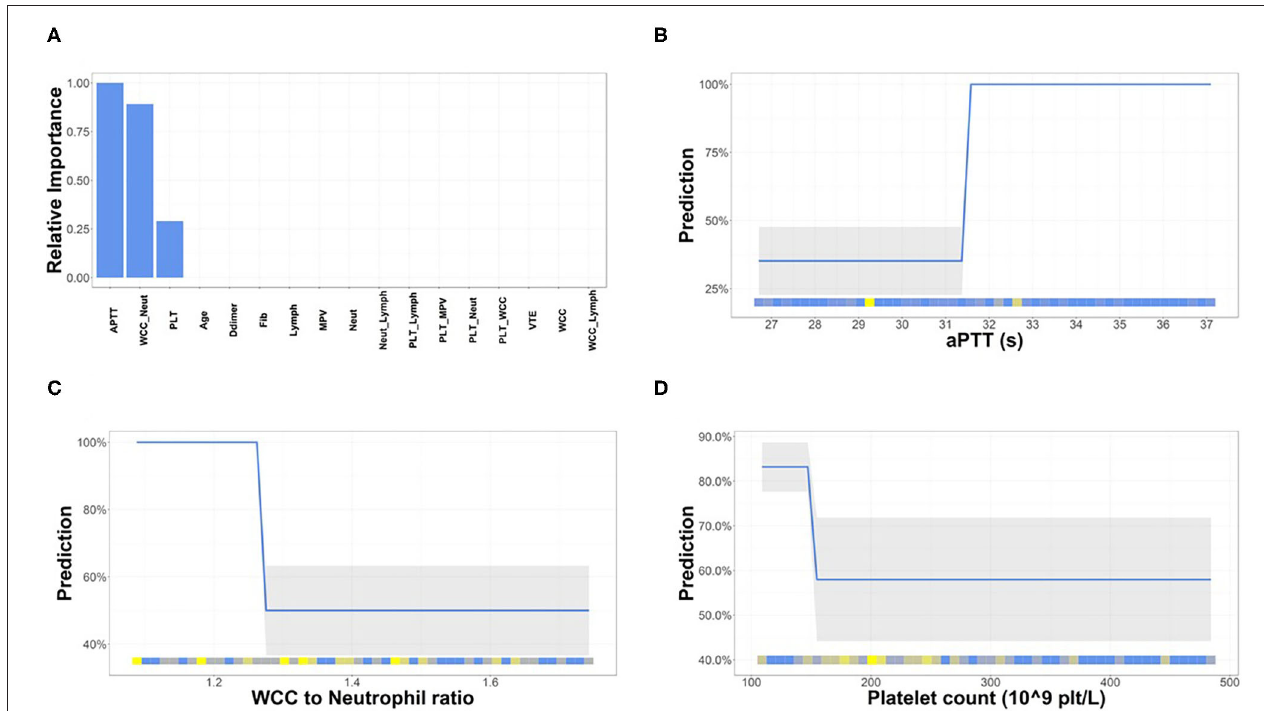
FIGURE 2 | Hematological parameters important for the prediction of severity of COVID-19. (A) Of the 20 parameters used for decision modeling, three were deemed the most important for the prediction of severity of COVID-19. The relationship between each parameter [aPTT (B) , white cell count (WCC)-to-neutophil ratio (C) , and platelet count (D) ] and predicted target was examined. The partial differentiation (PD) plots show that an aPTT > 31.58s, WCC-to-neutophil ratio < 1.088, and platelet count < 108.83 × 10 9 platelets/L are indicative of COVID-19